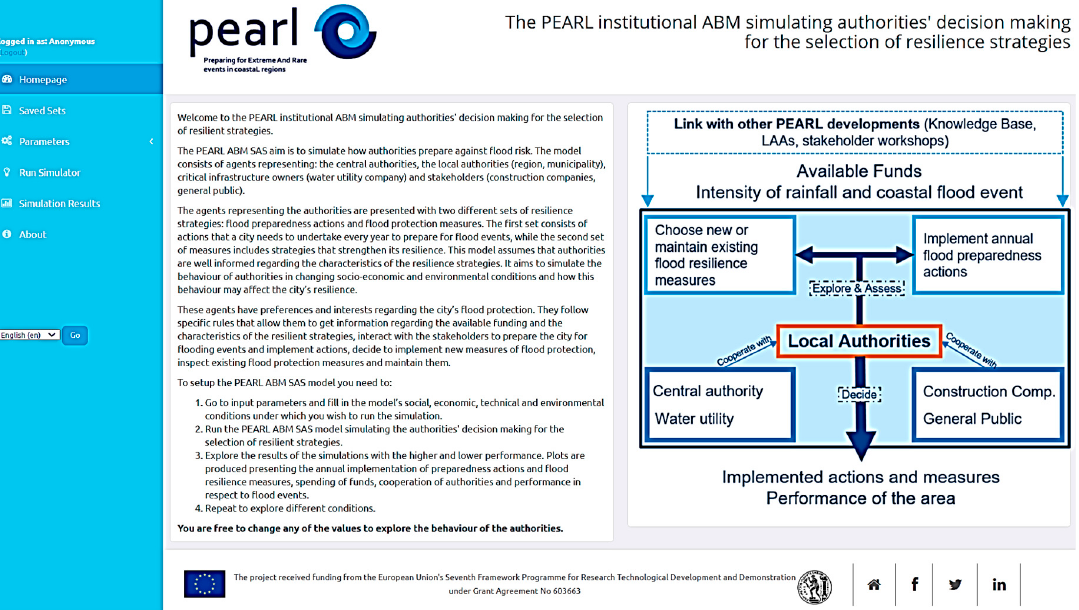
Figure 7. Homepage of the PEARL institutional ABM simulating authorities’ decision making for the selection of resilience strategies.